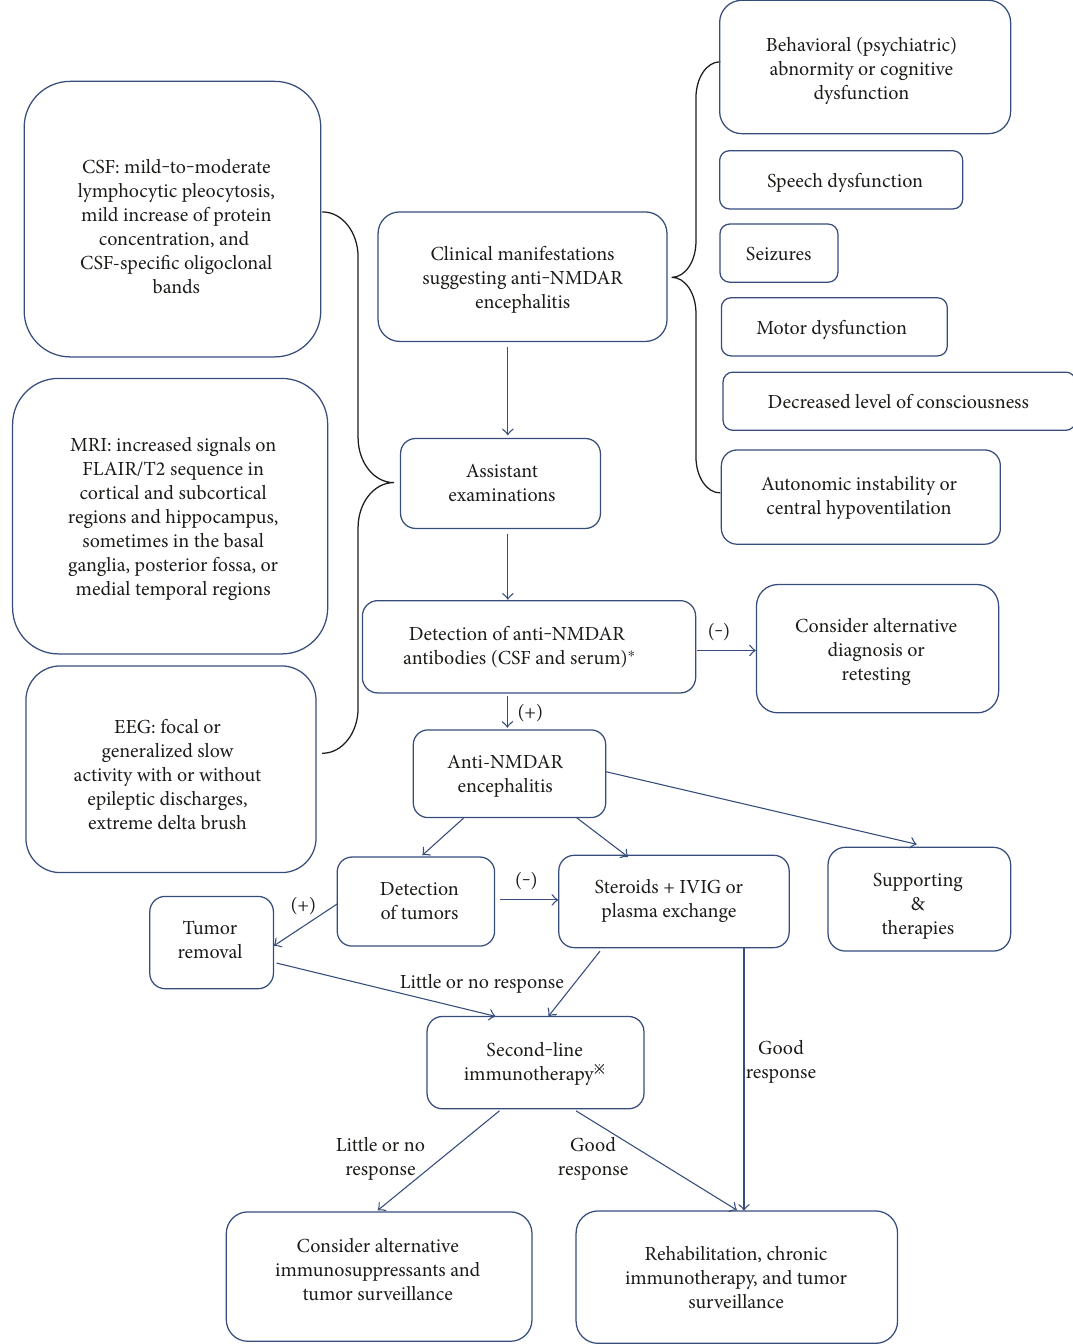
Figure 2: Procedure of diagnosis and treatment of anti-NMDAR encephalitis. ∗ indicates that detection of antibodies should include CSF analysis. If only serum is available, in addition to cell-based assay (CBA), live neurons or tissue immunohistochemistry should be used as con fi rmatory test. & Supporting therapies include antiepileptic and antipsychotic treatments, respiratory and cardiac support, management of blood pressure and temperature, and prevention of deep venous thrombosis (DVT) and bedsore. ※ Cyclophosphamide, rituximab, or